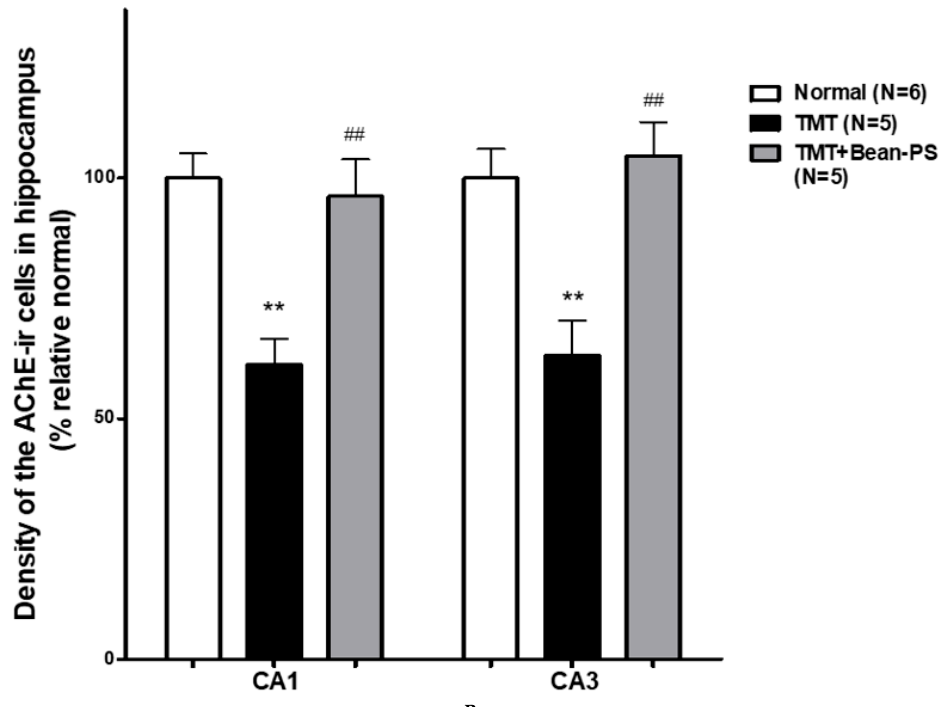
Figure 4. Effect of Bean-PS on the density of acetylcholinersterase (AchE)-immunostained nuclei in the hippocampus. Representative photographs and the density of AchE-immunostained nuclei are indicated in ( A ) and ( B ). Black square represents region of CA1 and CA3 in the hippocampus and the scale bar represents 200 μ m. The values are presented as means ± S.E.M. ** p < 0.01 vs. normal group, ## p < 0.01 vs. TMT group, respectively. Normal group ( N = 6); TMT group ( N = 5); TMT-Bean-PS ( N = 5).